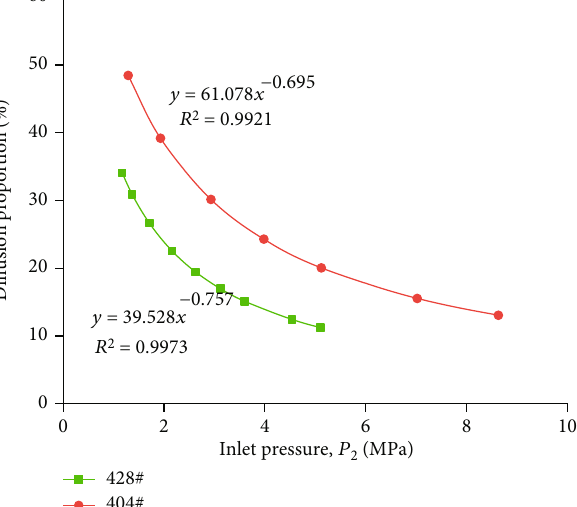
Figure 7: Di ff usion ’ s contribution under di ff erent inlet